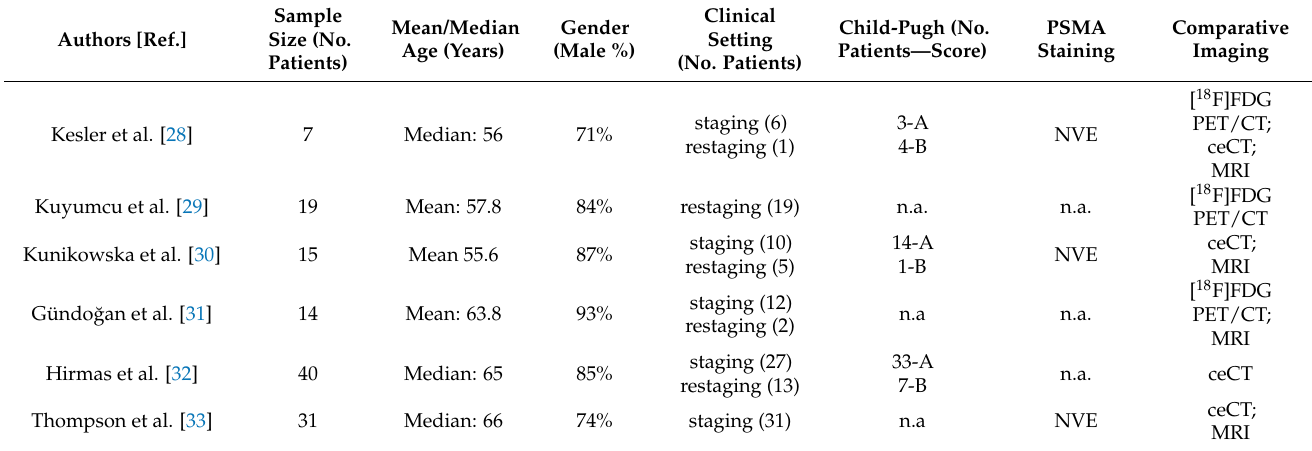
Table 2. Patient key characteristics and clinical